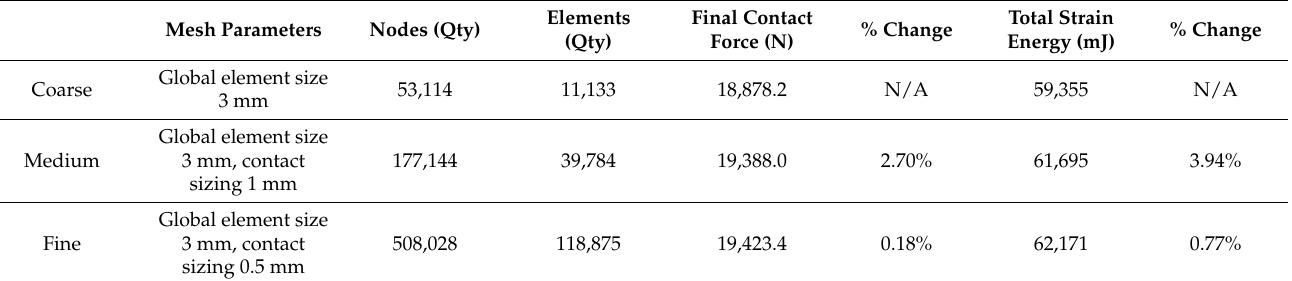
Table 1. Mesh convergence results obtained from a representative archway structure ( θ = 20°, r = 3 mm, and L = 4 mm). Quadratic elements were used in all three cases. The percent change indicates the percent change in the model output compared with the previous mesh (i.e., from coarse to medium and from medium to fine).